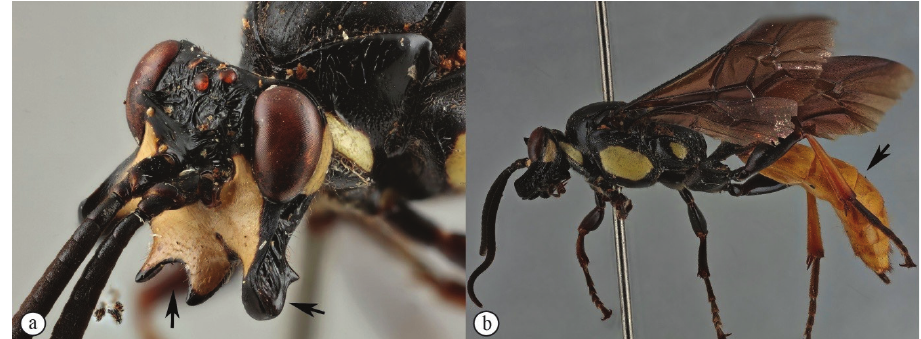
– Clypeus apically deeply emarginate, gena dramatically protruded (a); meta-